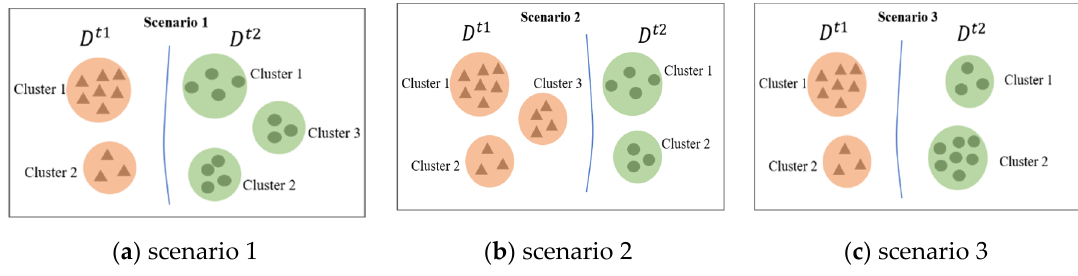
Figure 5. Three basic pattern-change scenarios.